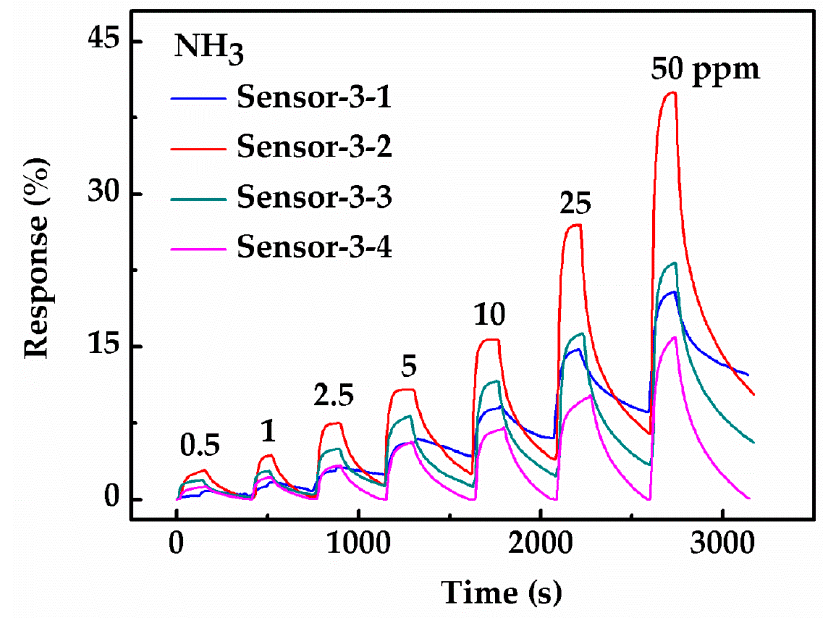
Figure 7. Gas sensing response of four hybrid sensors under seven different ammonia concentrations (0.5, 1, 2.5, 5, 10, 25, 50 ppm).